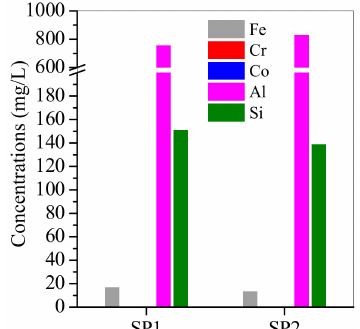
Figure 4. Concentrations of heavy metals in the supernatant after the hydrothermal process.